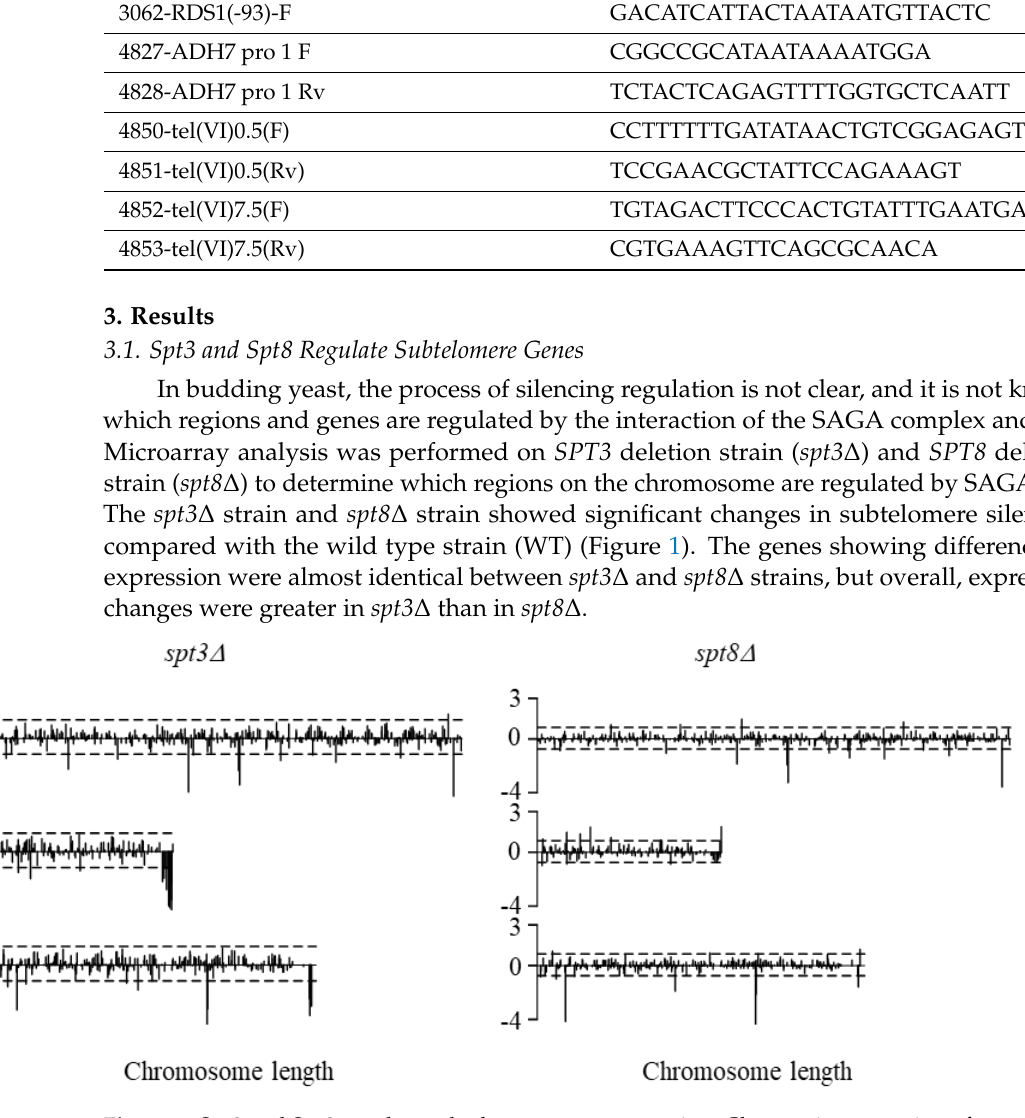
Figure 1. Spt3 and Spt8 regulate subtelomere gene expression. Changes in expression of genes from Chr II, III, and VIII in the spt3 ∆ and spt8 ∆ and the wild type (WT) strains as determined by microarray. Dotted lines show the average ± 2 x standard deviation.